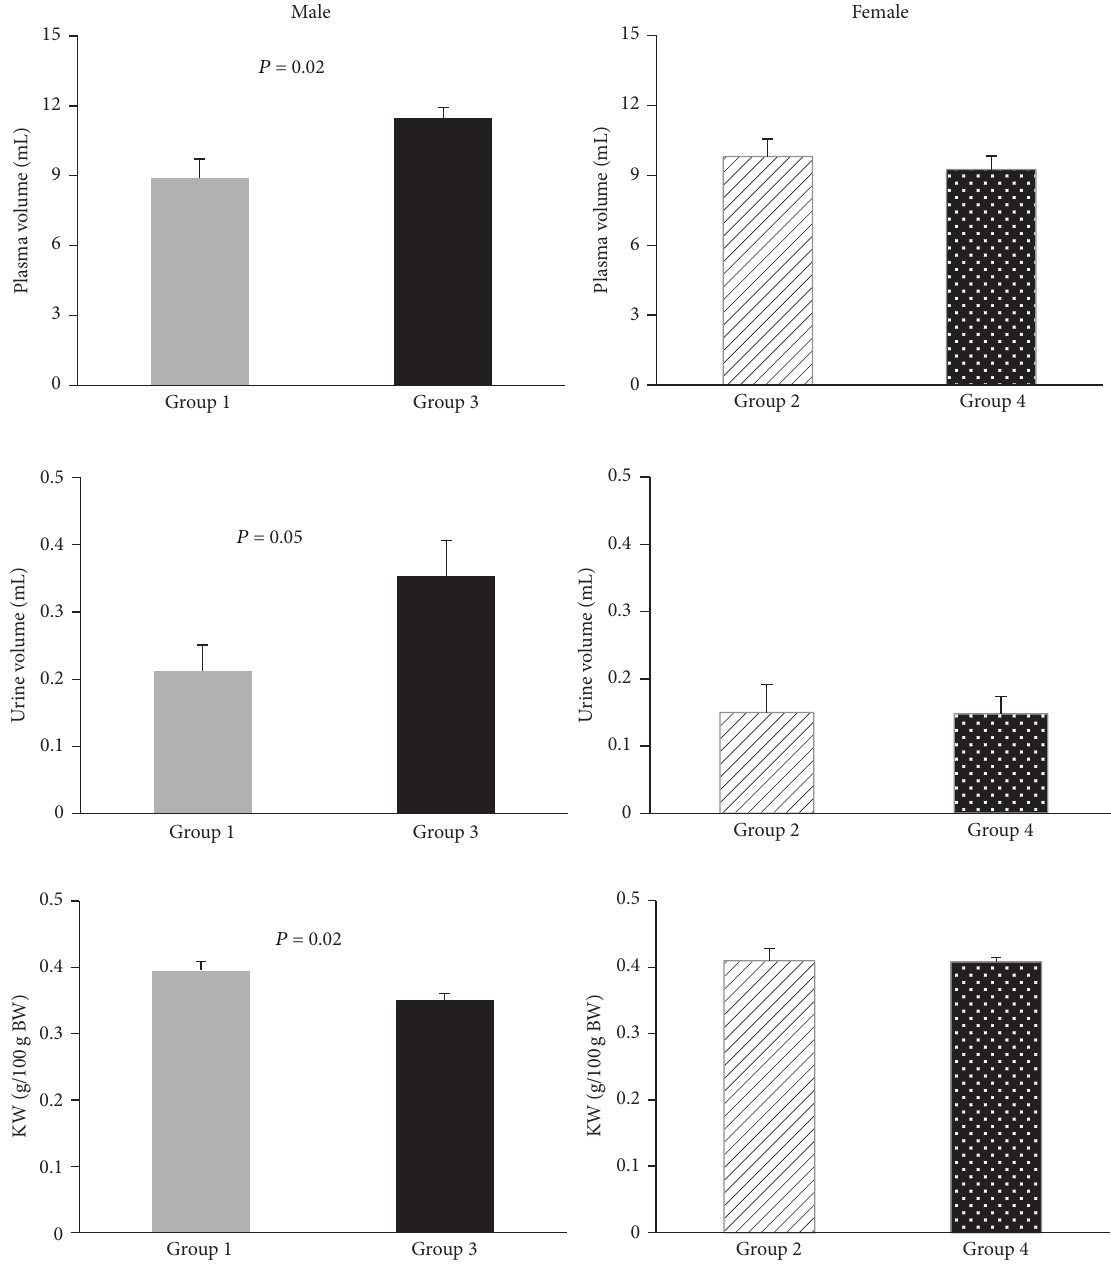
Figure 2: Body weight, urine output response to AngII infusion, and kidney weight in male (groups 1 and 3) and female (groups 2 and 4) offspring (adult). Groups 1 and 2: male (group 1) and female (group 2) offspring from mothers who received tap water during pregnancy. Groups 3 and 4: male (group 3) and female (group 4) offspring from mothers who received high-salt water during